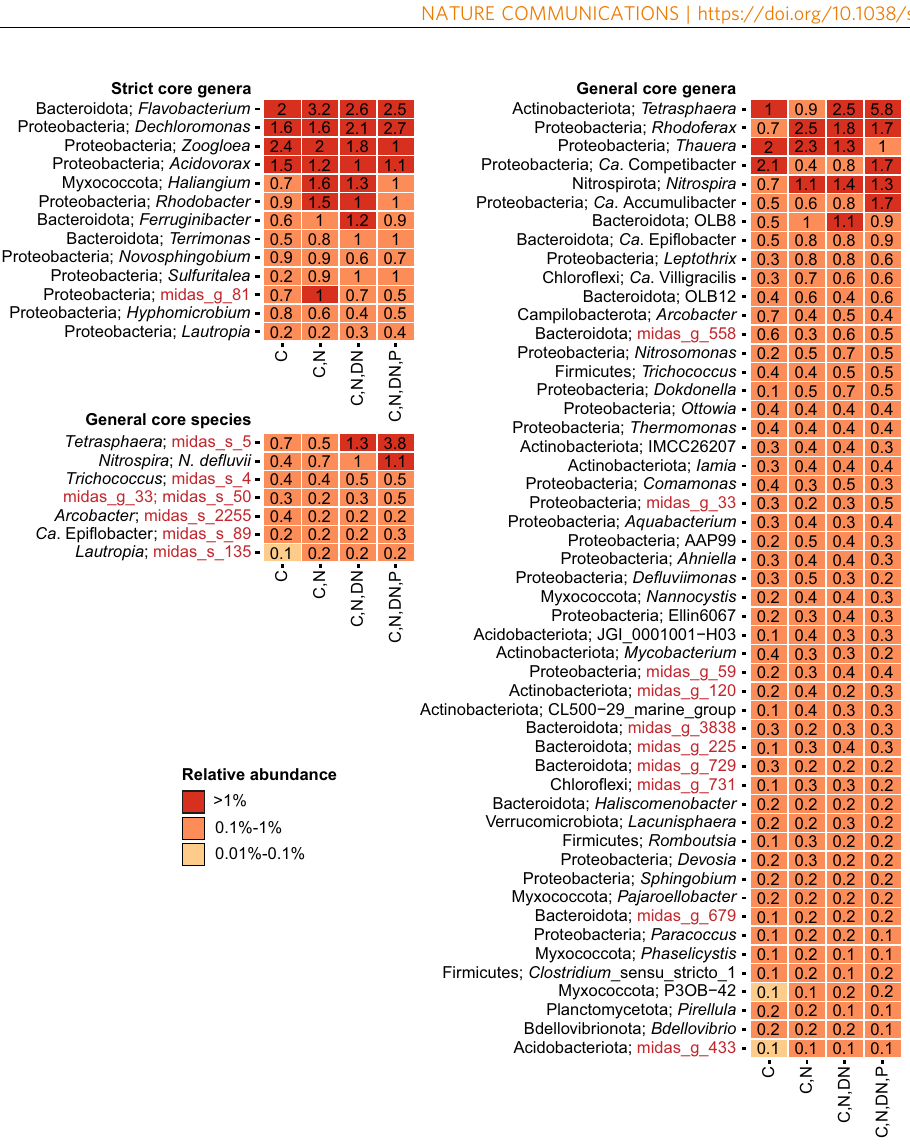
Fig. 7 Percent relative abundance of strict and general core taxa across process types. The taxonomy for the core genera indicates phylum and genus. For general core species, genus names are also provided. De novo taxa in the core are highlighted in red. C carbon removal, C,N carbon removal with nitri fi cation, C,N,DN carbon removal with nitri fi cation and denitri fi cation, C,N,DN,P carbon removal with nitrogen removal and enhanced biological phosphorus removal